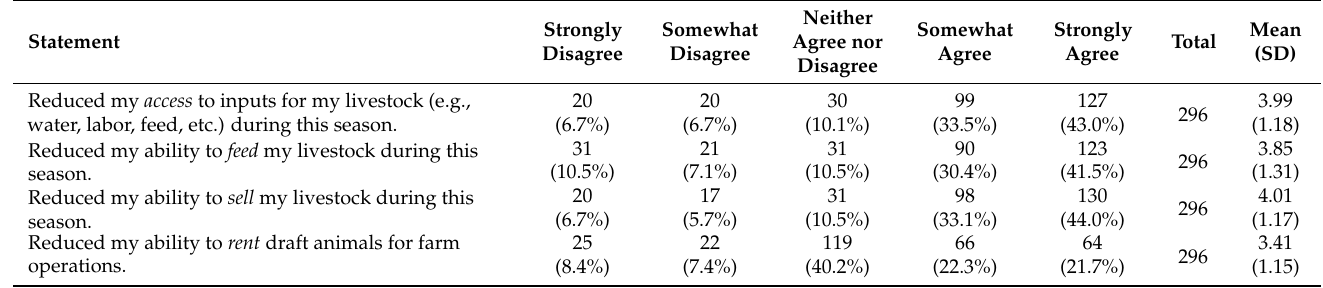
Table 5. Thinking about your experience of what has occurred due to COVID-19, please indicate your agreement or disagreement with the following